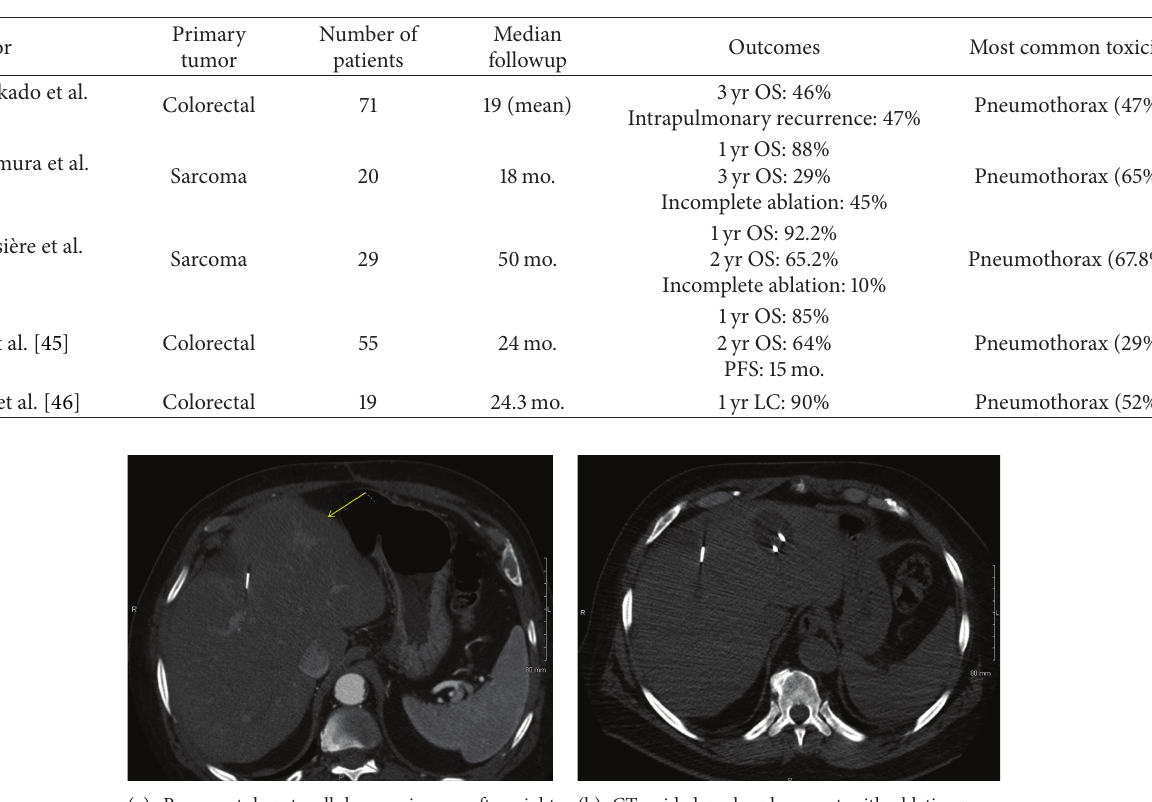
Figure 3: Recurrent hepatocellular carcinoma after right lobe resection (a) and ablation zone